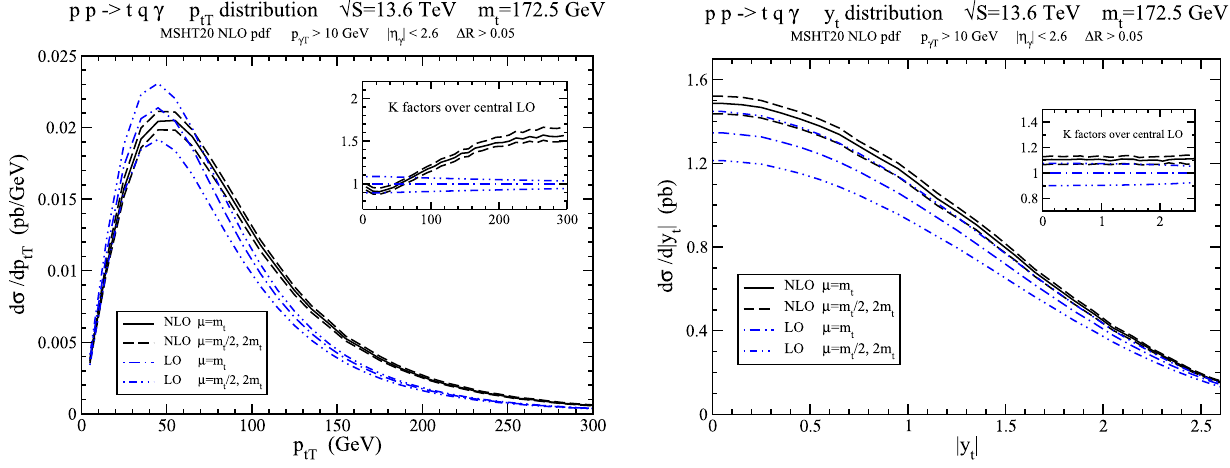
Fig. 4 The LO and NLO top-quark p T (left) and rapidity (right) distributions in tq γ production at 13.6 TeV LHC energy